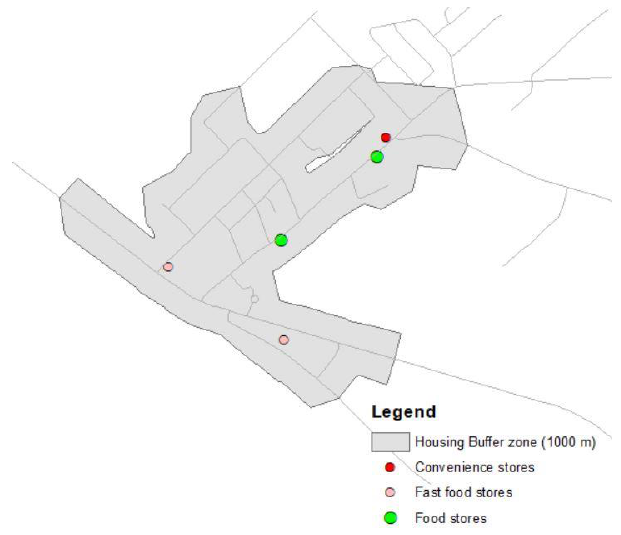
Figure 2. RFEI calculation method.